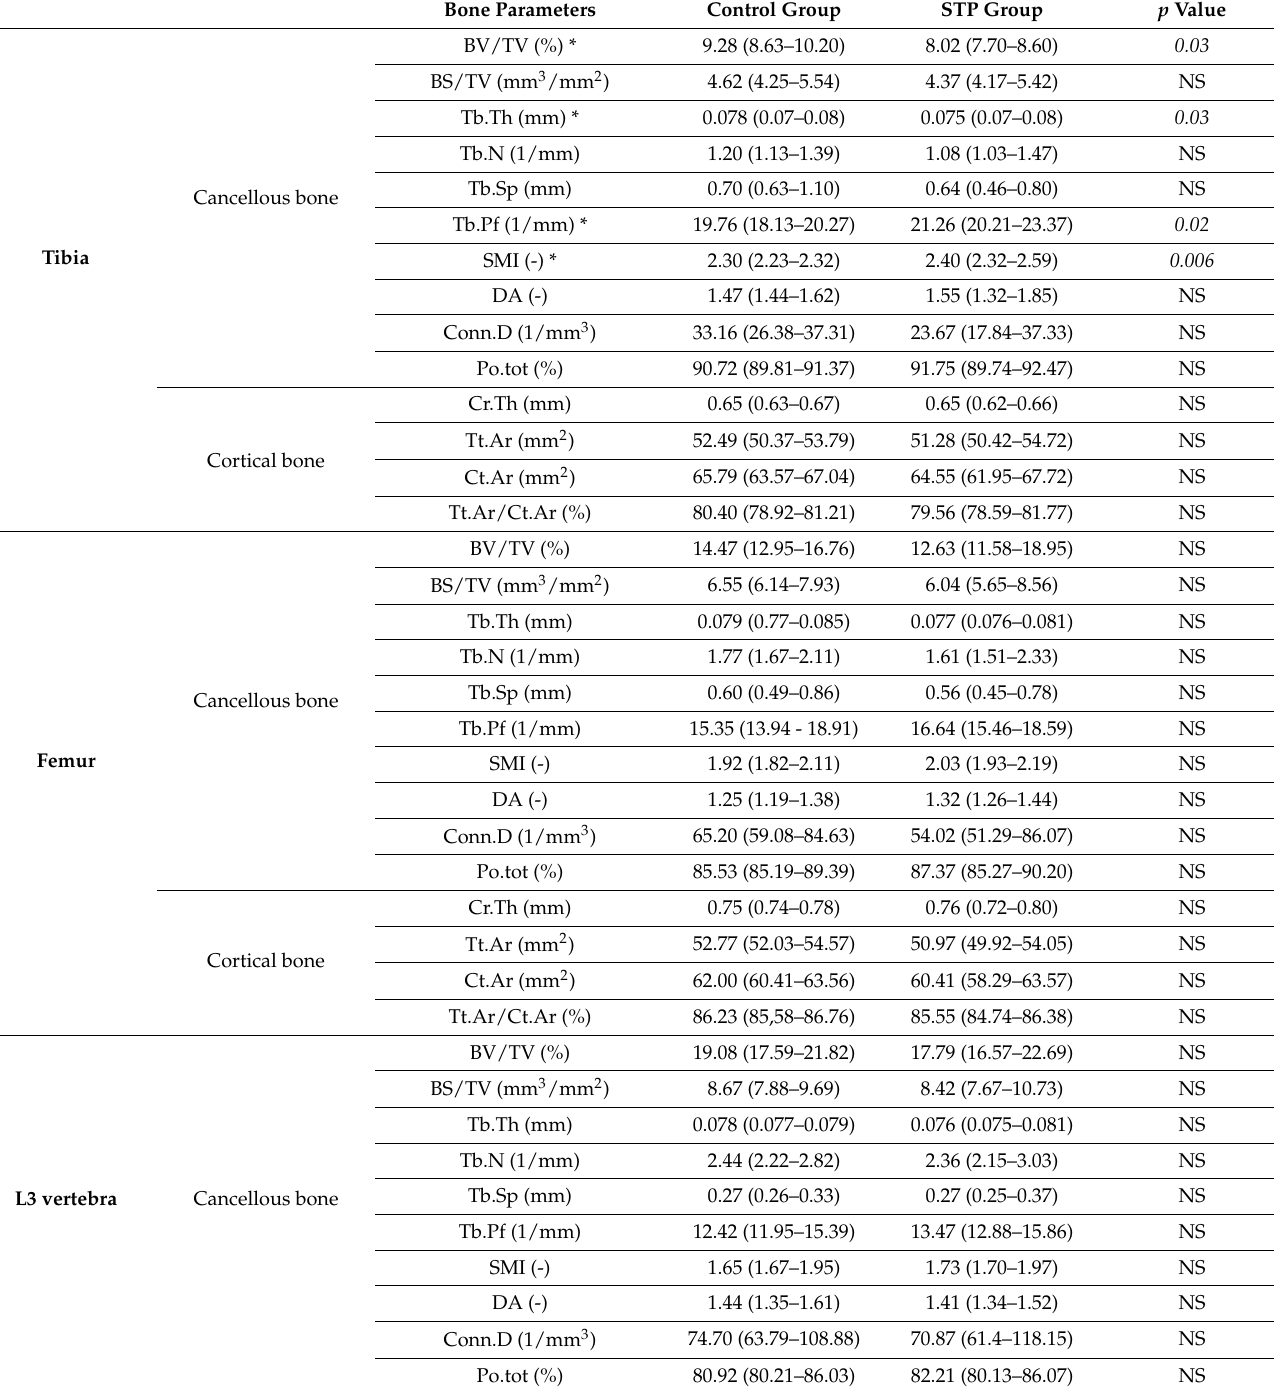
Table 4. The effect of 24 weeks administration of stiripentol on parameters of bone assessed using micro X-ray computed tomography (BV/TV—bone volume fraction; BS/TV—bone surface density; Tb.Th—trabecular thickness; Tb.N—trabecular number; Tb.Sp—trabecular separation; Tb.Pf—trabecular pattern factor; SMI—structure model index; DA—degree of anisotropy; Conn.D—connectivity density; Po.tot—total porosity; Ct.Th—average cortical thickness; Tt.Ar—total cross- sectional area inside the periosteal envelope; Ct.Ar—cortical bone area; Ct.Ar/Tt.Ar—cortical area fraction; L3